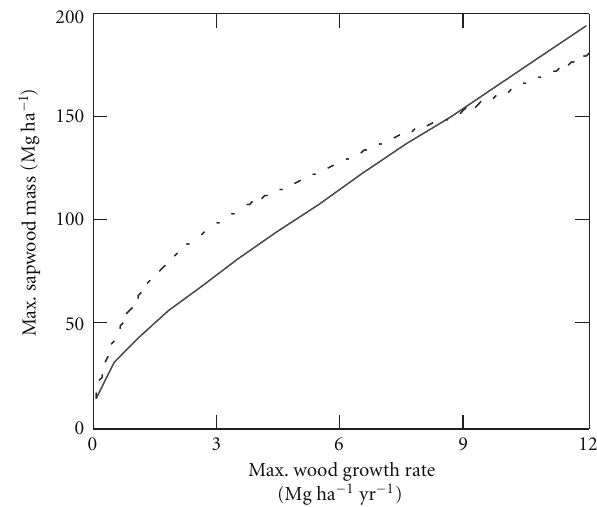
Figure 1: Contrasting increment versus biomass relationships for Pinus sylvestris (lower lines) and Populus species (upper lines). Rate of net biomass increment from yield table (open symbols) and modeled ((11), solid line). Gross production (net increment + mortality) from yield table (closed squares) and modeled ((12), dotted line). The higher β 2 and lower β 0 of Pinus compared to Populus ((1)–(3), Table 2) lead to the contrasting relationships for the two species.